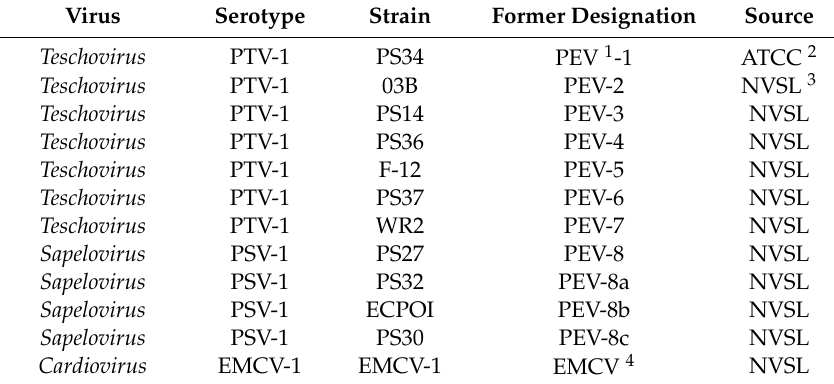
Table 1. Reference Porcine teschovirus (PTV), Porcine sapelovirus (PSV) and EMCV serotypes and their respective strains used in this